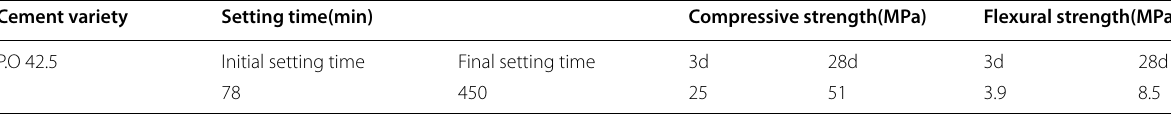
Table 1 Main performance test table of cement Cement variety